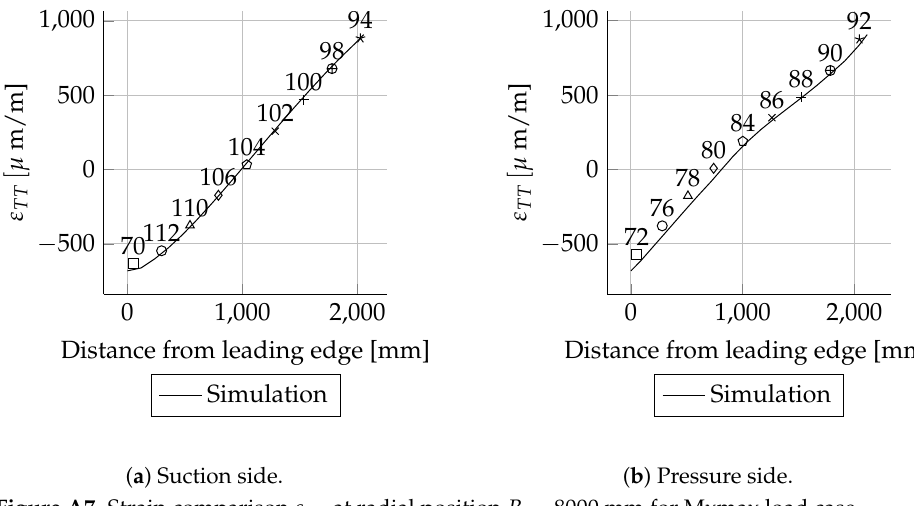
Figure A7. Strain comparison ε LL at radial position R = 8000 mm for Mxmax load case.